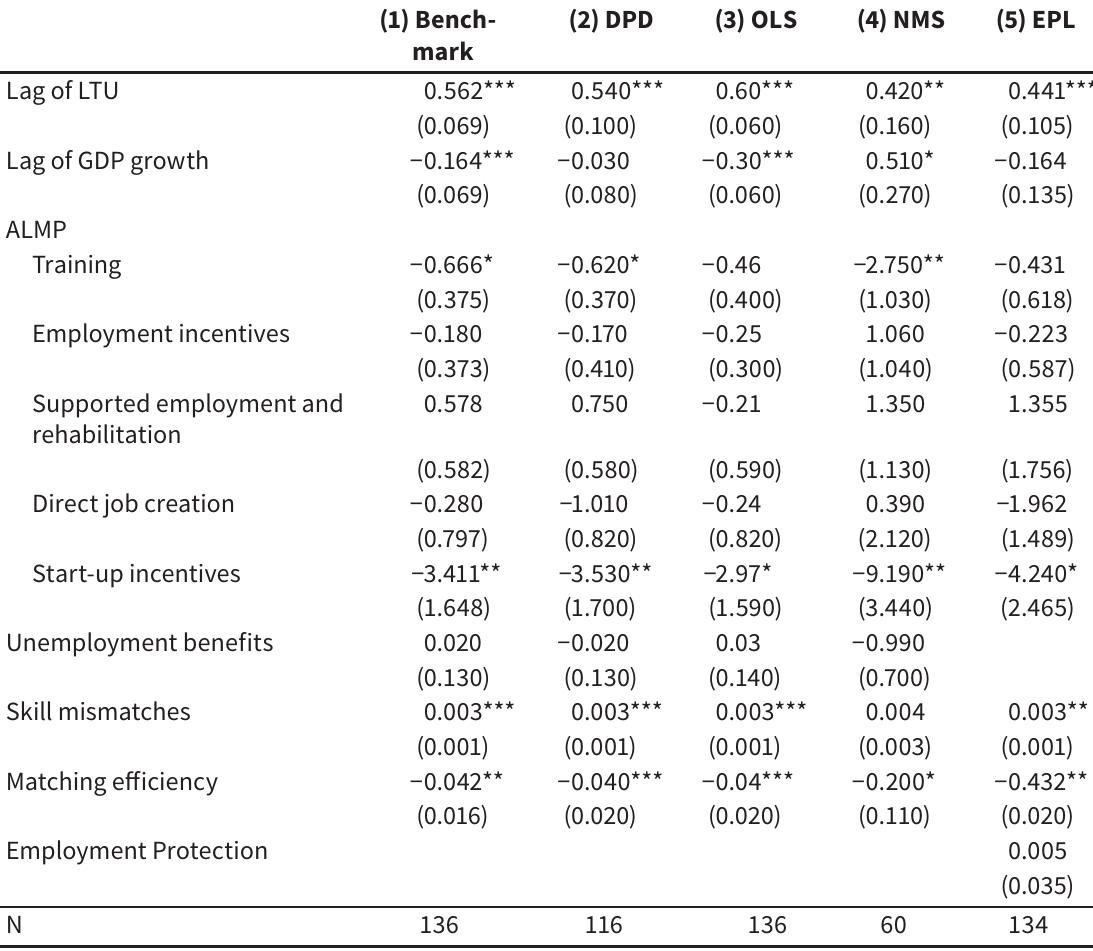
Robustness check Dependent Variable: Incidence of